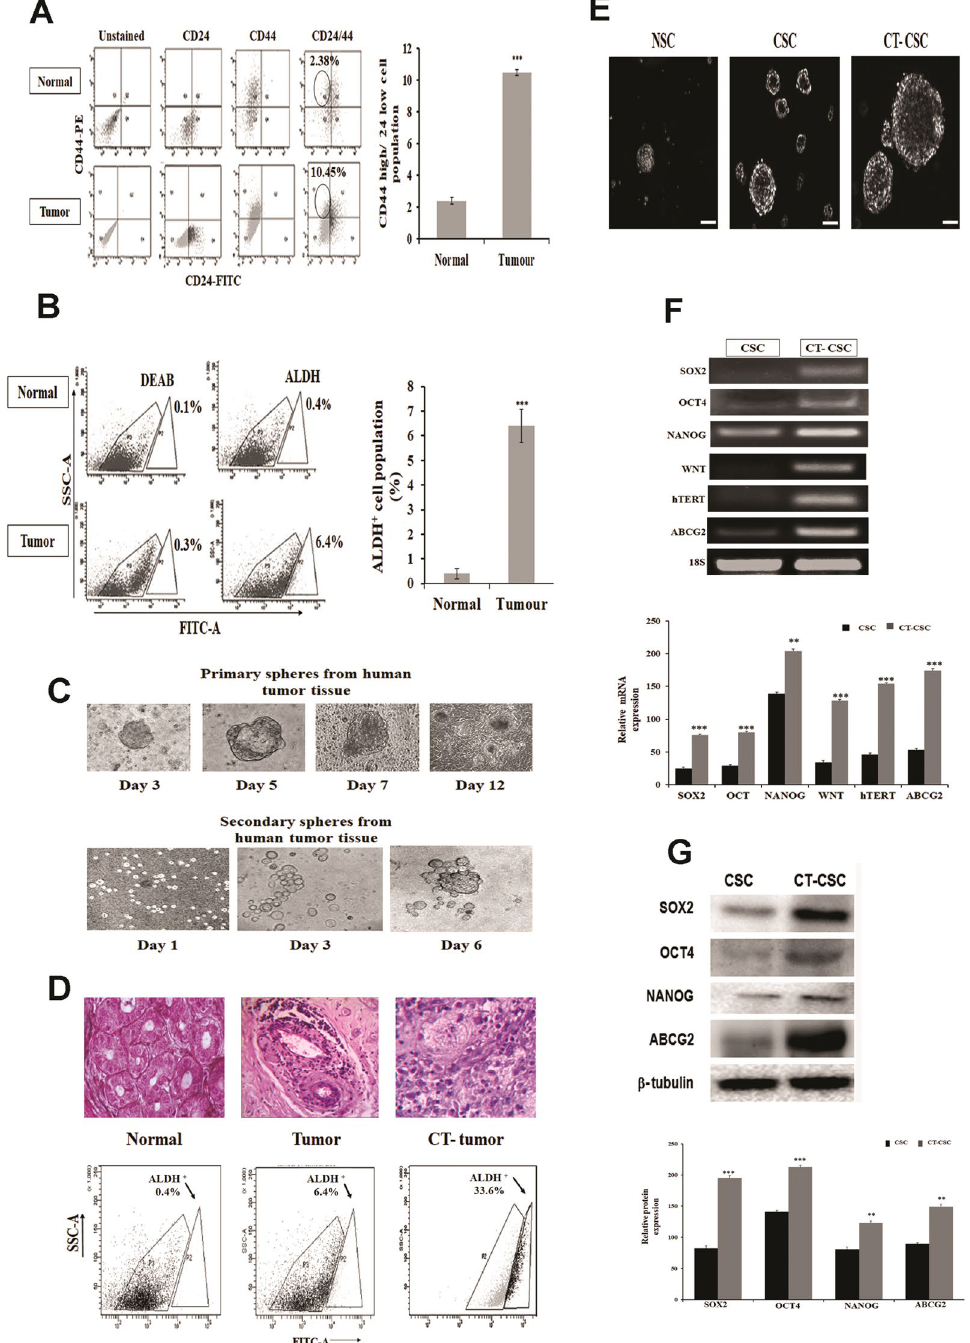
Figure 1. Breast cancer stem cells show higher expression of pluripotency genes and chemoresistance marker. ( A ) Immunesorting of normal mammary tissues and breast tumor tissues showing 10.45% cells with CD44 + / CD24 − phenotype in tumors as compared to 2.38% in normal tissues (n = 50). ( B ) Aldefluor assays from patient tumors show a higher percentage of ALDH + cells (6.4%) as compared to normal tissues (0.4%) (n = 50). ( C ) Representative images showing the morphology of primary and secondary mammospheres grown in serum-free cultures from TNBC tumors (20X magnification; n = 30). ( D ) Representative hematoxylin-eosin staining of normal mammary tissue and TNBC tumor obtained after MRM surgery from naïve (Tumor) and chemo-treated (CT-Tumor) patients. Aldefluor assays show 33.6% ALDH + cells in the CT-tumor (n = 30). ( E ) Mammospheres formed from sorted normal stem cells (NSC), cancer stem cells from untreated TNBC tumor (CSC) and cancer stem cells from TNBC CT-tumor (CT-CSC) after 7 days of culture (20X magnification). ( F ) Expressions of SOX2, OCT4, NANOG, WNT, hTERT and ABCG2 in sorted ALDH + populations of TNBC tumor (CSC) and chemo-treated TNBC tumor (CT-CSC). 18S was used as the endogenous control. The color bars represent expression of markers in CSCs (darker bars) versus chemo-treated CSCs (lighter bars) ( G ) Western blot analyses of SOX2, OCT4, NANOG and ABCG2 in breast cancer stem cells isolated from